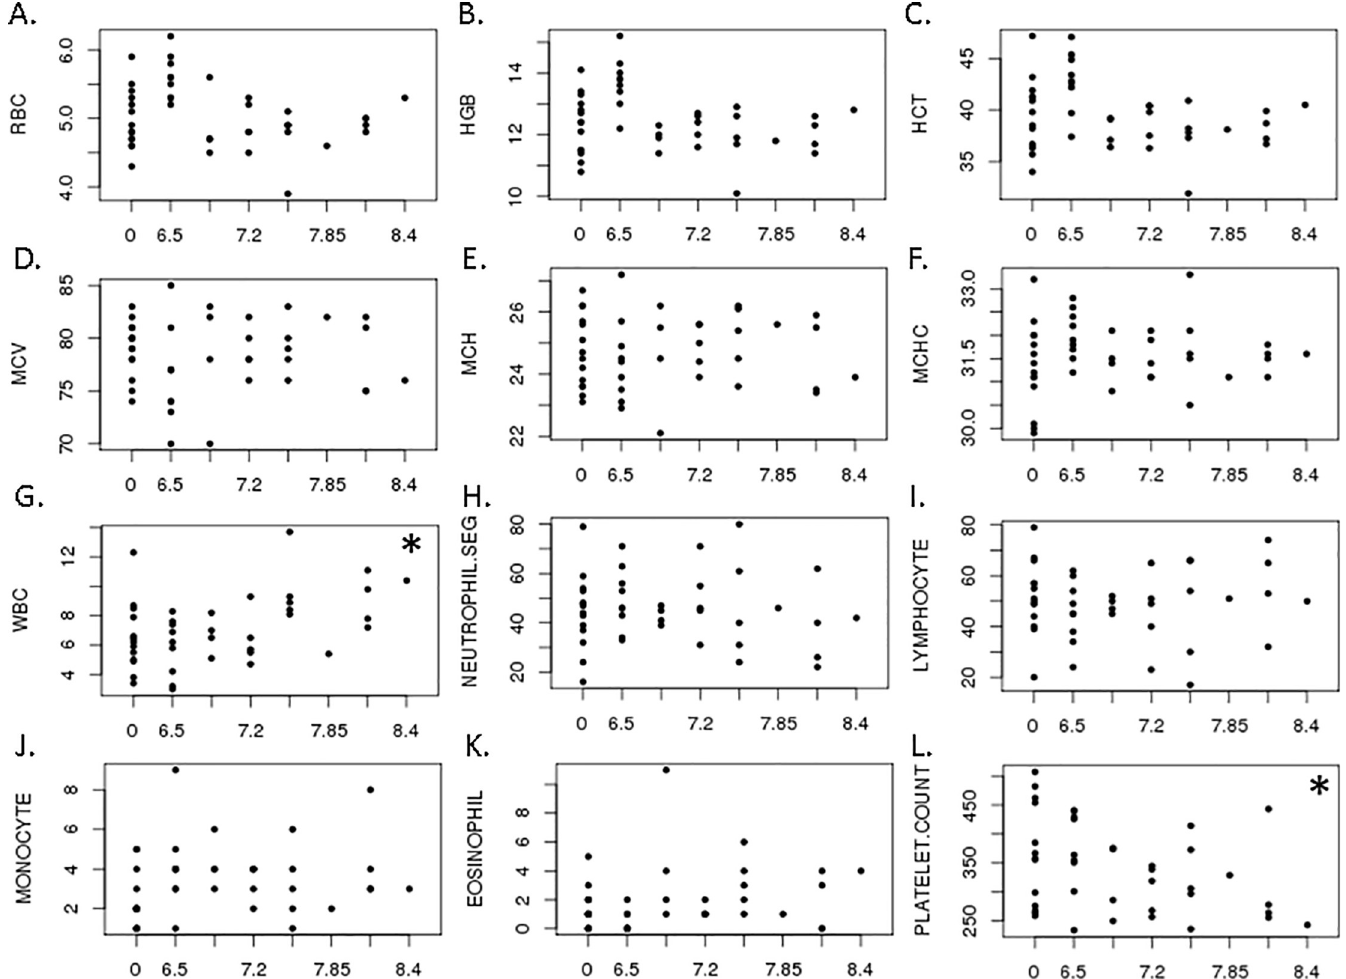
Fig 2. Hematologic parameters at a median of 55 months (~ 5 years) post-irradiation. Values of each parameter are shown as a function of radiation dose in Gy (x- axis for all plots); 0 Gy represents the control group. Each point represents a different subject (n = 43). A . Red blood cell (RBC) concentration, cells x 10 6 / μ L; B . Hemoglobin (Hgb), g/dL; C . Hematocrit (Hct), %; D . Mean corpuscular volume (MCV), fL; E . Mean cellular hemoglobin, (MCH), pg; F . Mean cellular hemoglobin concentration (MCHC), g/dL; G . White blood cells (WBC), cells x 10 3 / μ L; H . Neutrophil %; I . Lymphocyte %; J . Monocyte %; K . Eosinophil %; L . Platelet count, x 10 3 / μ L. Asterisk ( � ) indicates p = 0.01 in panel G and p = 0.05 in panel L for dose-based comparison of irradiated and control animals using the Jonckheere-Terpstra test. Raw data are provided in S1 Table.